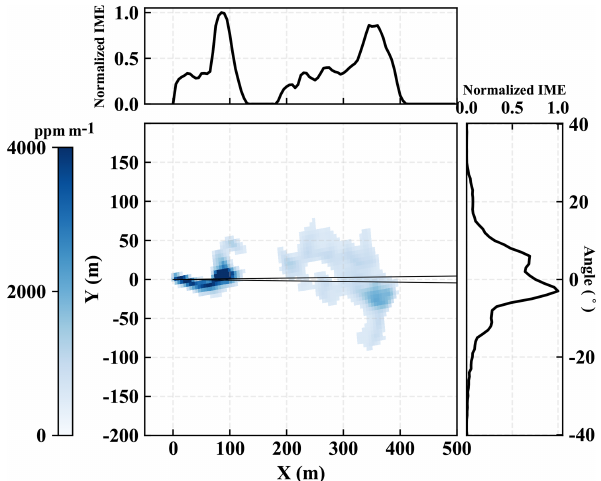
Figure 8. A rotated plume snapshot from a run of 4ms − 1 back- ground wind speed and 300kgh − 1 flux rate with its angular distri- bution of IME across the plume (right) and its Cartesian distribution of IME along the plume (top). The two black lines denote an angu- lar bin of 0.5 ◦ that sweeps through the 2-D plume to construct the angular distribution.